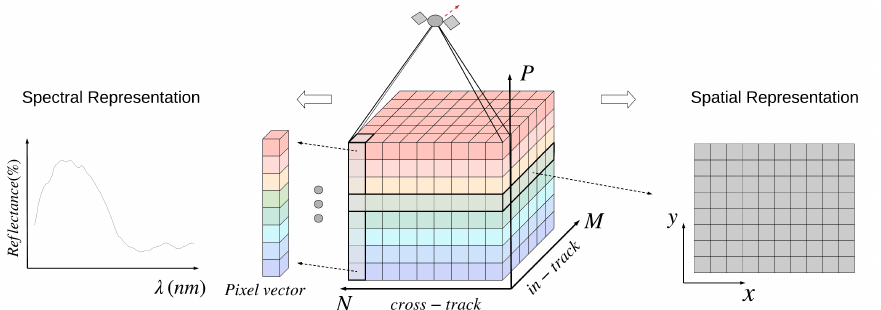
Figure 1. A representation of a hyperspectral data cube acquired by a pushbroom scanner and a pixel vector with the corresponding spectral